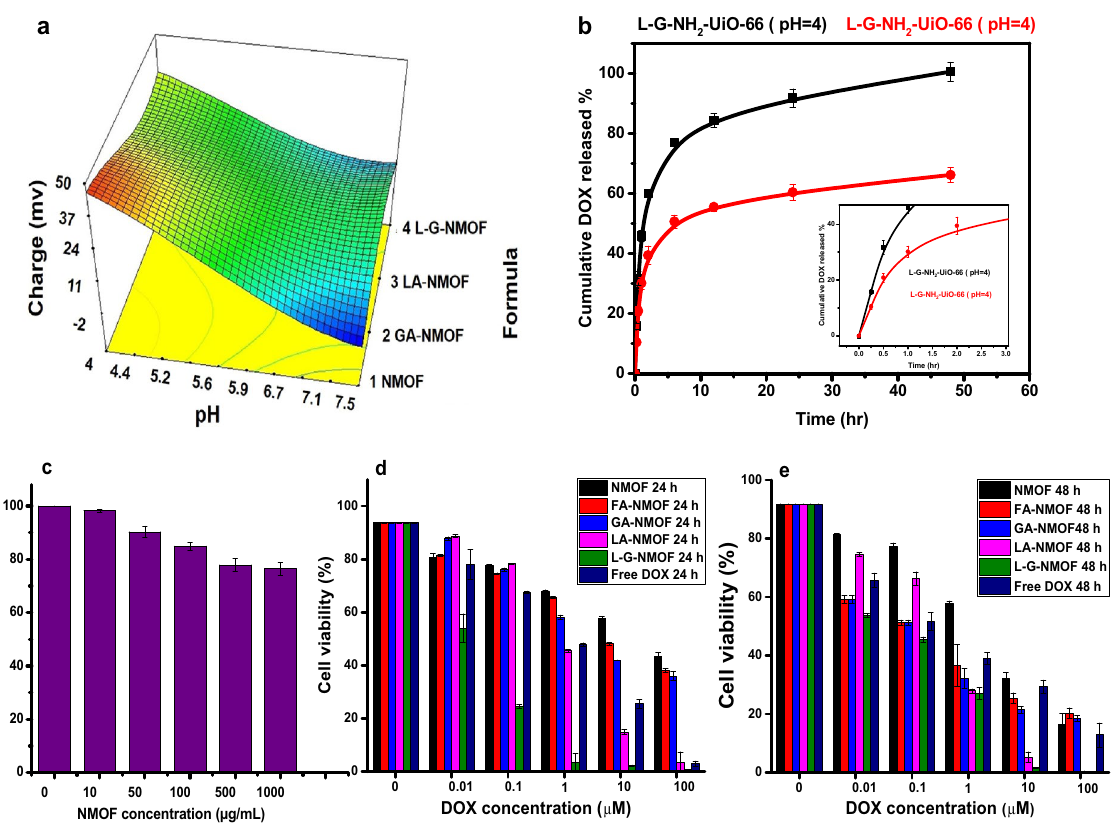
Figure 5. ( a ) chart showing the effect of pH change on the zeta potential values of developed NMOFs formulas, ( b ) In-vitro drug release from LA-GA-NMOF at different pHs (4 and 7.4) with a focus on the release profile during the first 3 h (inset), ( c ) cytocompatibility study using HSF cells post-treatment with different concentrations of pristine NMOF for 72 h. ( d , e ) HepG2 cell viabilities post-incubation with free DOX and DOX-loaded NMOFs for 24 h ( d ) and 48 h ( e